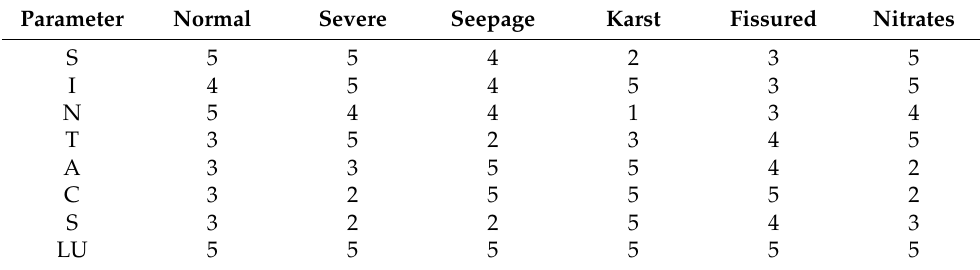
Table 2. Strings of multiplier weights given for SINTACS (modified from [44]). Parameter